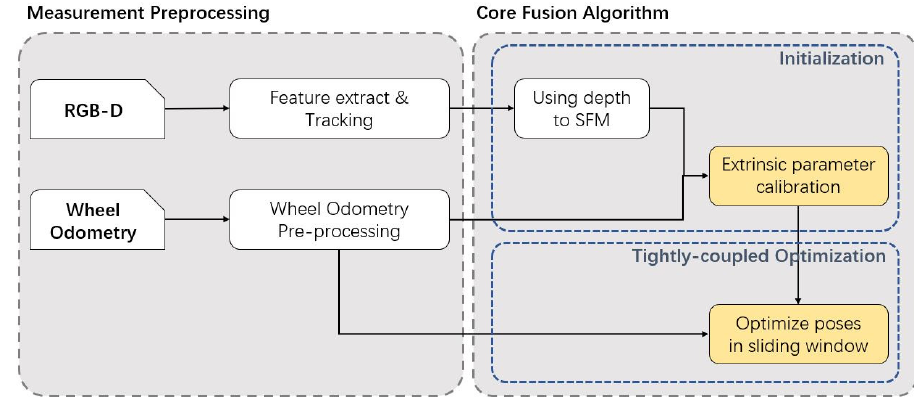
Figure 2. Algorithm framework of the proposed fusion positioning